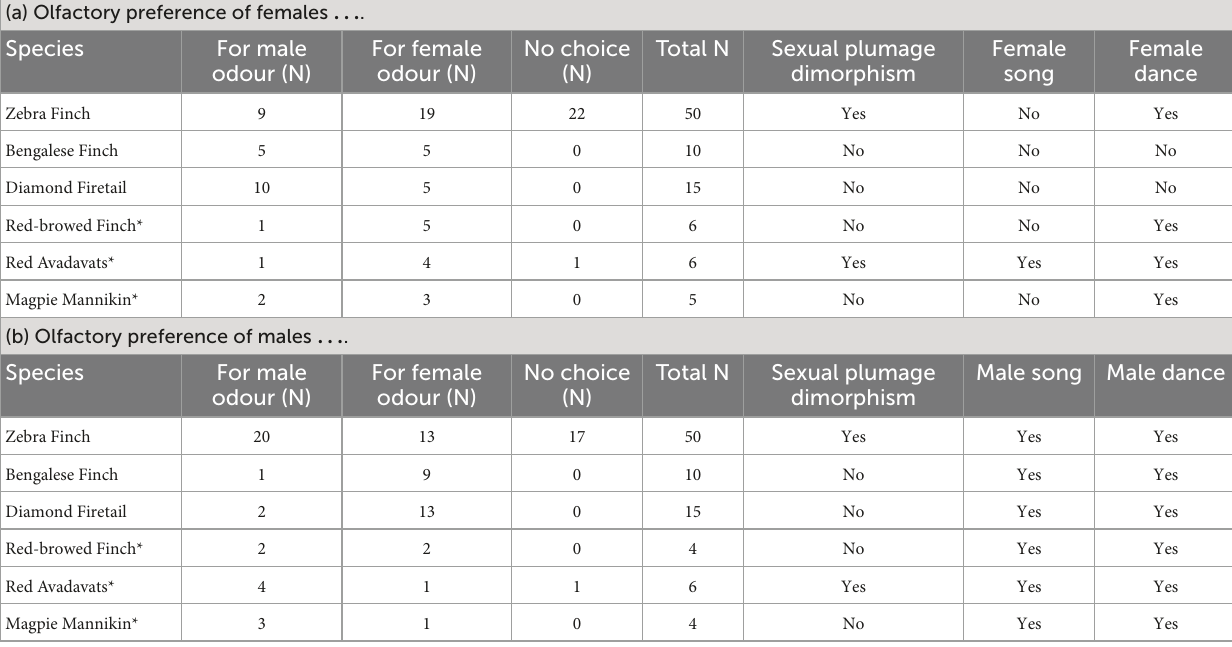
TABLE 1 Results from the olfactory Y-maze test and selected species-specific characteristics from the six Estrildid Finch species used in the study as extracted from the literature (see text for references) for (a) females and (b) males. (a) Olfactory preference of females ...